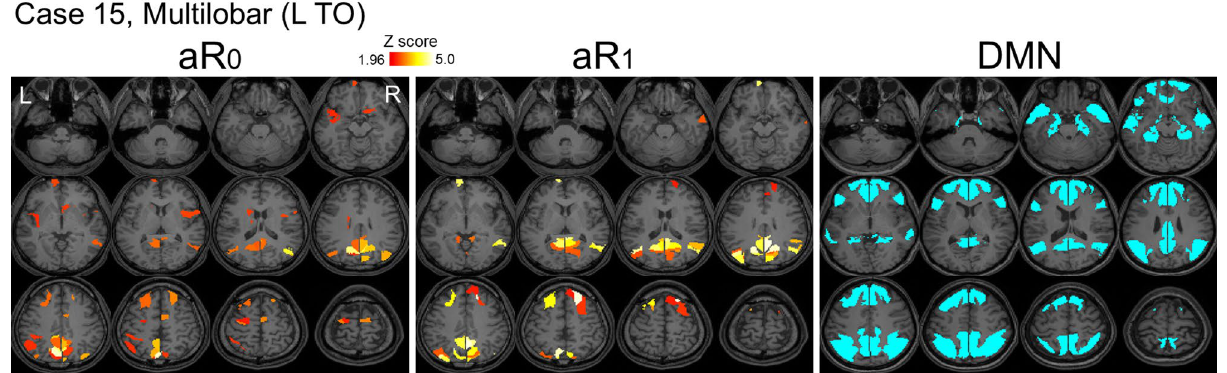
Figure 5. Abnormal regions were found with the default mode network for some patients. The spatial distribution of abnormal aR 0 and aR 1 of representative case (case 15) and the regions of the default mode network (DMN) are shown. This patient had 19 of 33 aR 0 regions (57.6%) and 26 of 41 aR 1 regions (63.4%) included in the DMN, which is significantly higher (p < 0.05, Chi-square test) than the expected value (25.8%). L TO left temporo-occipital